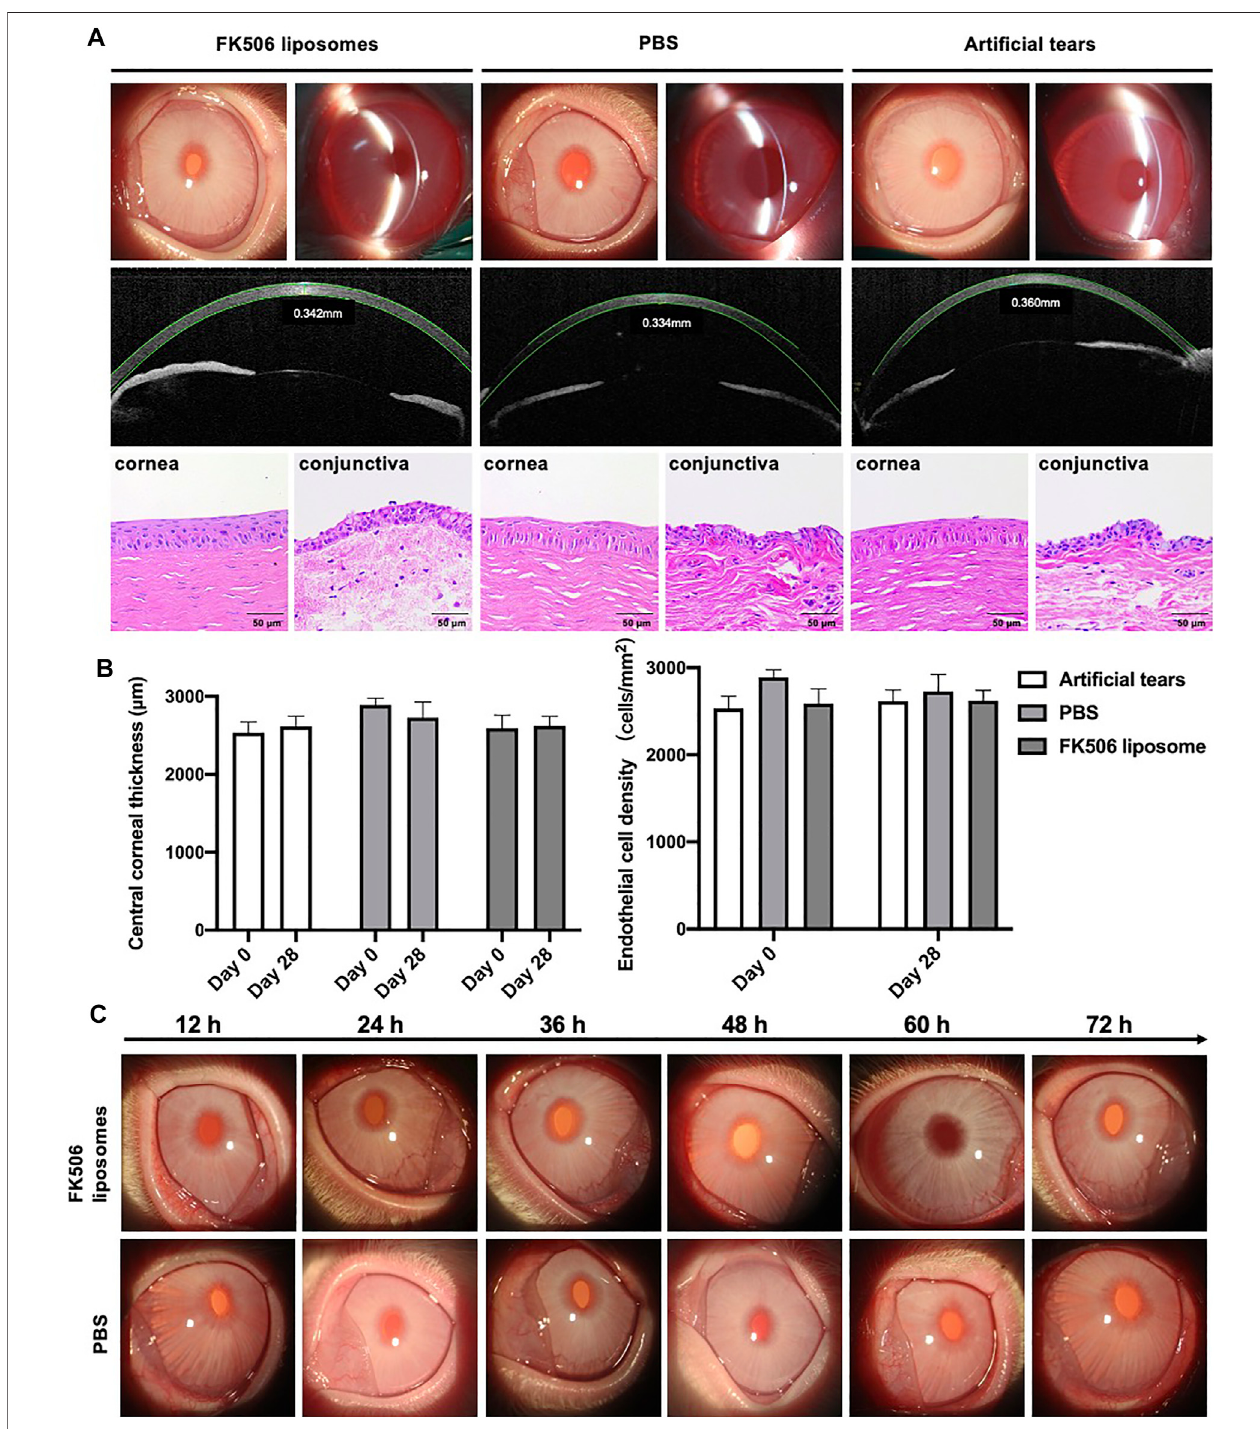
FIGURE3| Invivo biocompatibilityandocularirritationevaluationofFK506liposomesinNewZealandrabbits. (A) Upperimage:anteriorsegmentimagesobserved by a slit-lamp microscope after the four-week administration of different eye drops. Middle image: corneal thickness measured by anterior segment optical coherence tomography after the 4-week administration of different eye drops. Lower image: H and E of the cornea (left) and conjunctiva (right) after the four-week administration of differenteyedrops. (B) Quantitativeanalysisofcentralcornealthickness(left)andendothelialcelldensity(right). (C) 72-hourobservationsoftheocularirritationtest. The above-described images belonged to the FK506 liposome group, and the below images belonged to the PBS group.